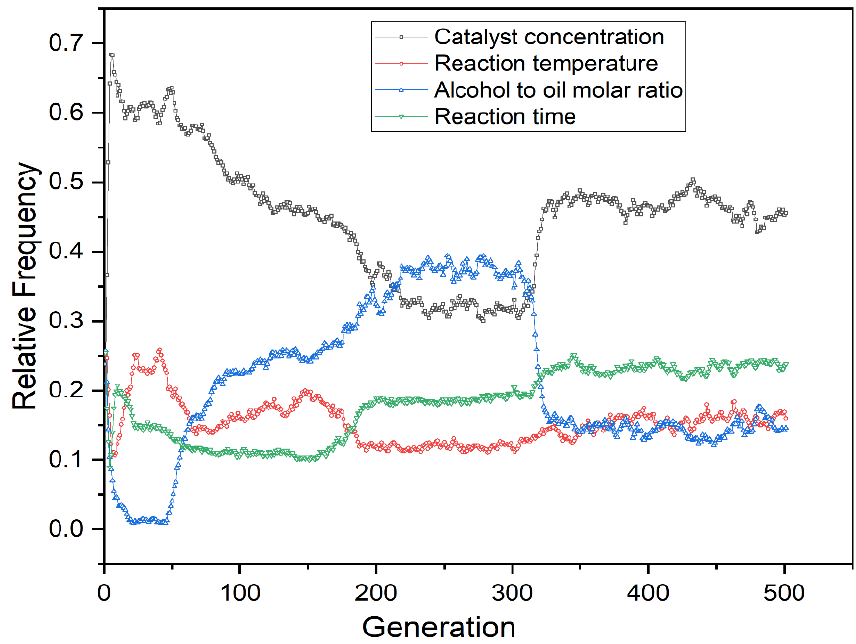
Figure 4. Relative occurrence frequency of various variables in GP trees over 500 generations.